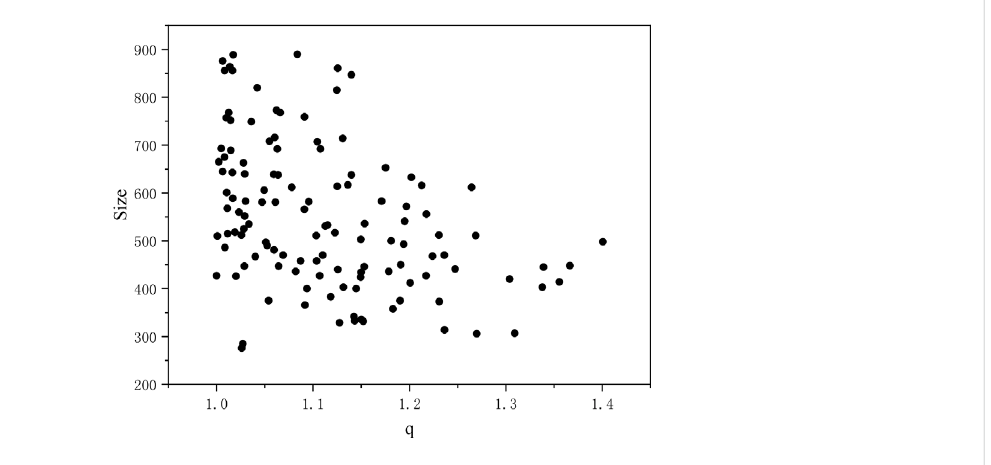
FIGURE 5 Relationship between q and the size of the courtyard